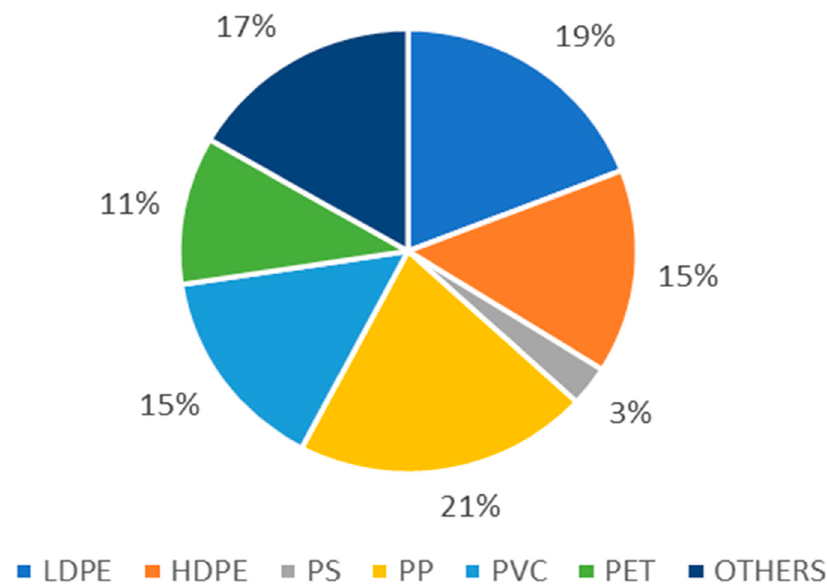
Figure 1. Distribution of primary plastics consumption in Ecuador for 2019 [9].